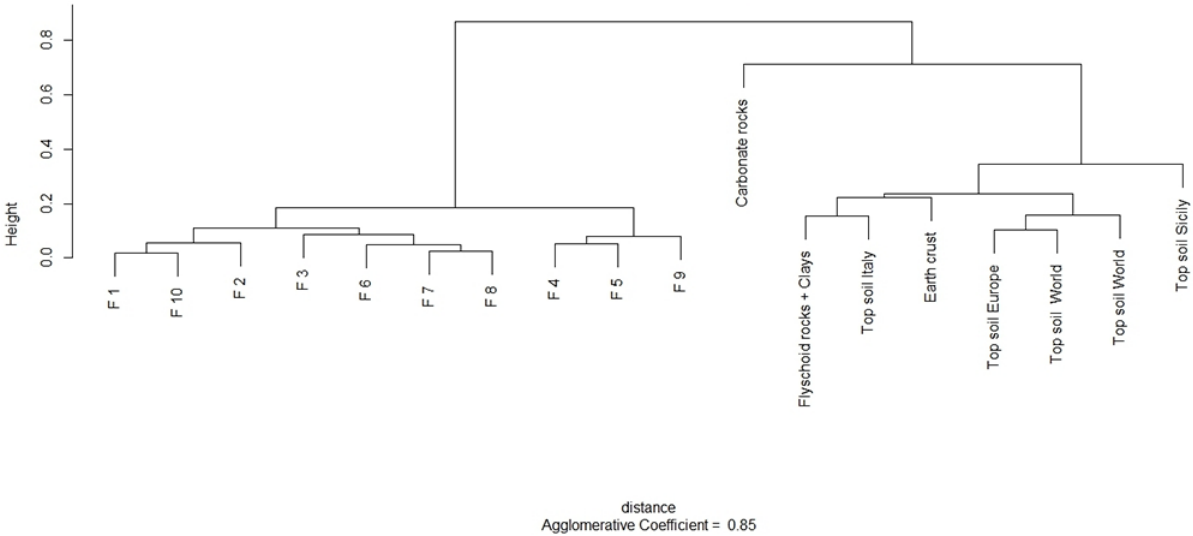
Fig. 5 Cluster dendrogram of matrix distance of the mushroom samples and soil types (carbonate rocks, Earth’s crust and topsoil from Sicily, Italy, Europe, and the rest of the world) based on the content of their elements.